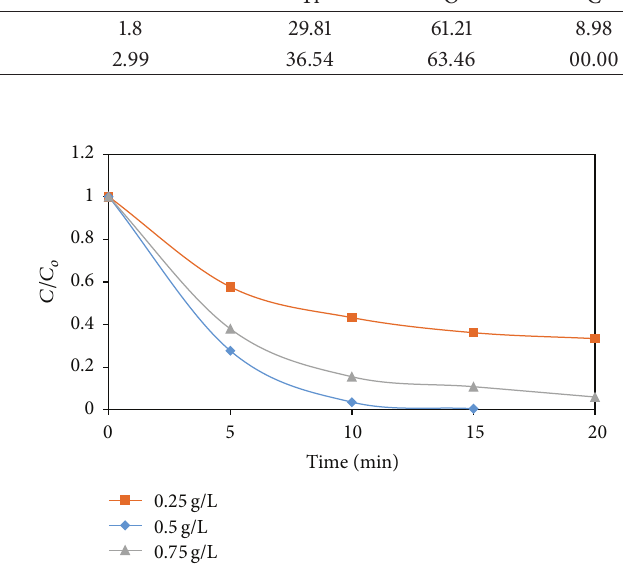
Figure 2: Effect of catalyst dose on the photocatalytic degradation of mixture of Ar 1254 (0.5ppm) and Ar 1260 (0.5 ppm) in seawater under illumination of UV light.